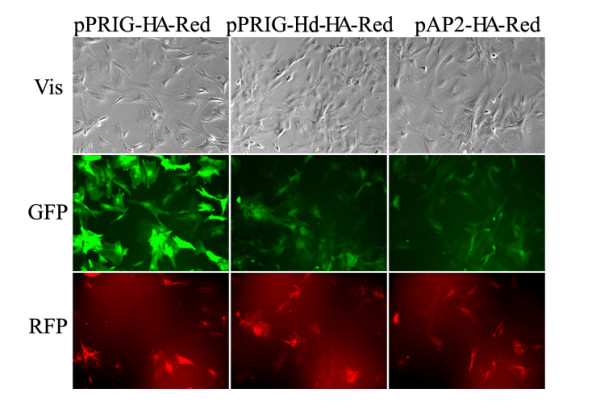
Comparison of stable pPRIG-HA-Red, pPRIG-Hd-HA-Red and pAP2-HA-Red expressions. HEK 293T cells were cotransfected with each vector and helper constructs. Viral supernatants were collected after 2 days and applied to primary rat embryo fibroblasts. The REF cells were photographed two weeks post-transduction. Vis: phase contrast image. Exposure time was the same for the three GFP images, as well as for the three RFP images. Fluorescence intensities are thus a direct reflection of protein expression levels.